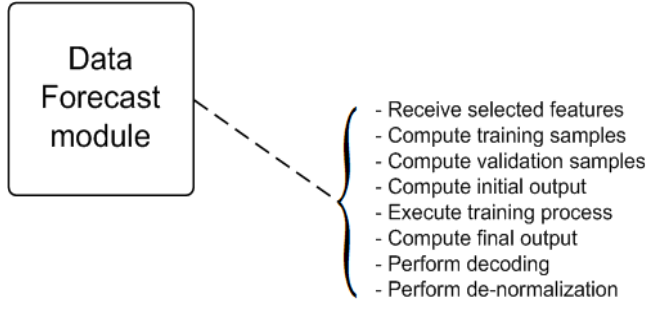
Figure 5. Data forecast